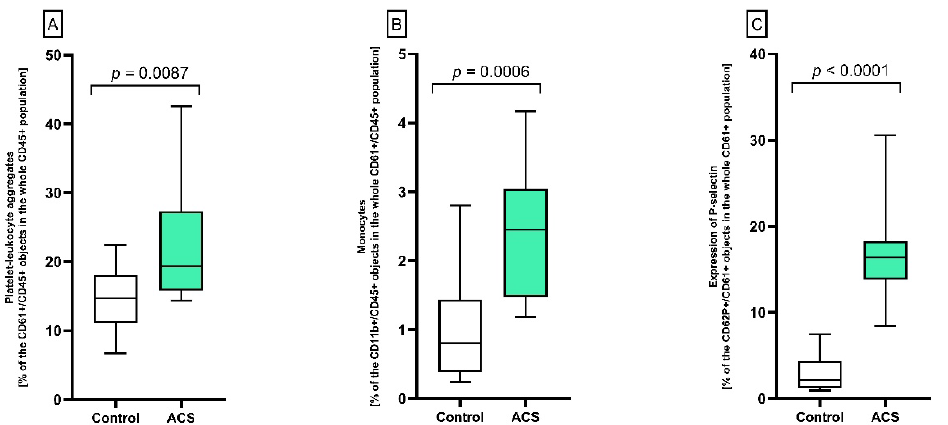
Figure 1. Analysis of PLA formation, monocyte participation, and platelet activation using double- label flow cytometry. The cells were distinguished based on the expression of CD61/FITC (platelets) or CD45/PE (leukocytes). For each sample, 15,000 CD61+ or CD45+ objects were acquired. ( A ) The formation of PLAs is shown as the percentage of CD61+/CD45+ objects in the whole CD45+ popula- tion. ( B ) Contribution of monocytes in whole CD61+/CD45+ population. Results are shown as the percentage of monocytes (CD11b+/CD45+ objects in the whole population of cells forming PLAs). ( C ) To assess CD62P (P-selectin) expression, samples were labeled with fluorescently conjugated monoclonal antibody CD62/PE, and the results are shown as the percentage of platelets expressing CD62P antigen (CD61+/CD62P+ objects in the whole CD61+ population). The results are represented on the box plots with the midpoint as median (the frame—the interquartile range quartiles: Q1–Q3; whiskers—the minimum and maximum value, respectively), n = 12. Statistical analysis was per- formed using the Mann–Whitney U test.